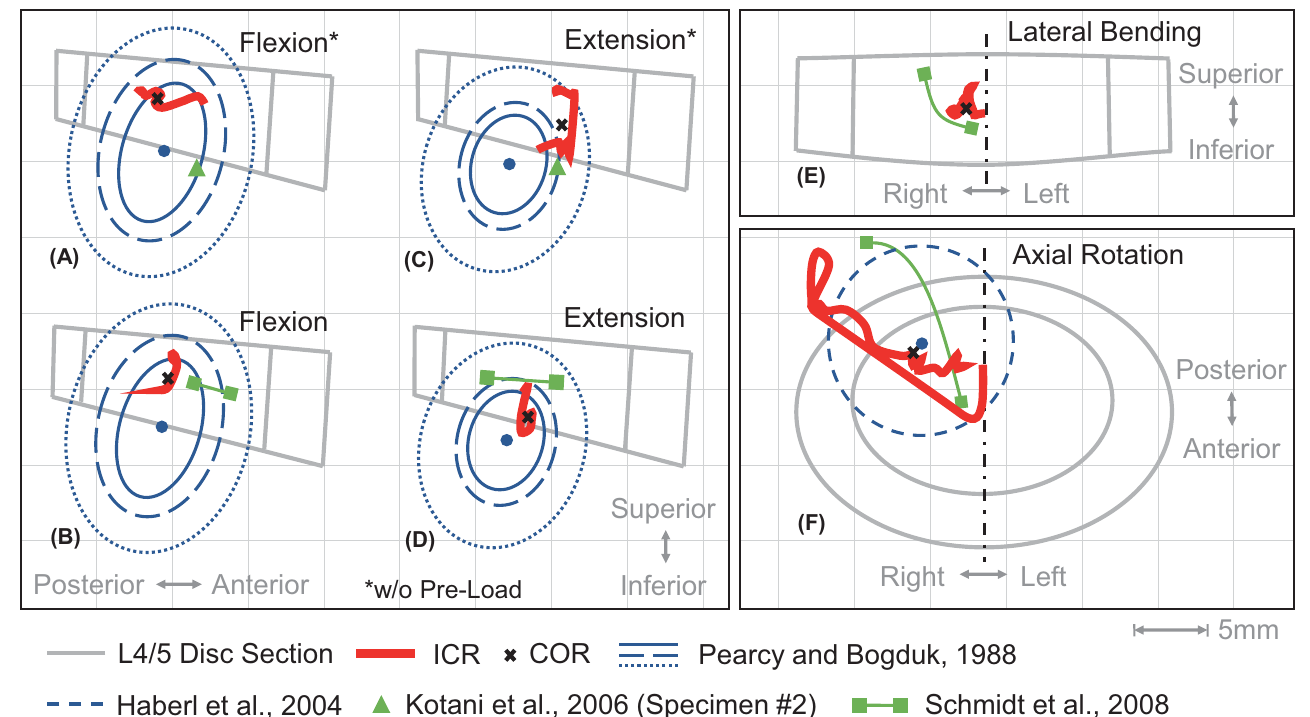
Fig 6. Centrodes traced by the ICR of vertebra L4 in flexion, extension, axial rotation, and lateral bending. As intersections of the instantaneous axes of rotation with the sagittal plane (A-D), the frontal plane at the center of L4/5 disc (E), or the superior endplate of vertebra L5 (F) the series of different ICR are shown as centrodes of motion (solid red line). To visualize the predicted centrodes with respect to an upright posture, the schematic L4/5 disc is shown in different sectional views: flexion and extension in lateral view (A-D), lateral bending (right) in dorsal view (E), and axial rotation (left) in caudal view (F). All applied moments are ramped from 0 to 10 Nm. For (B), (D), (E), and (F) L4 is additionally pre-loaded with 400 N by means of a FL. Mean ICR along the entire movements are visualized as COR (black cross). For comparison predicted ICR paths reported by Schmidt et al. [121], in vitro measured preoperative COR from Kotani et al. [132], the range of in vitro measured ICR with pre-load from Haberl et al. [128], and various confidence limits from in vivo ICR measurements from Pearcy and Bogduk [122] are transferred and